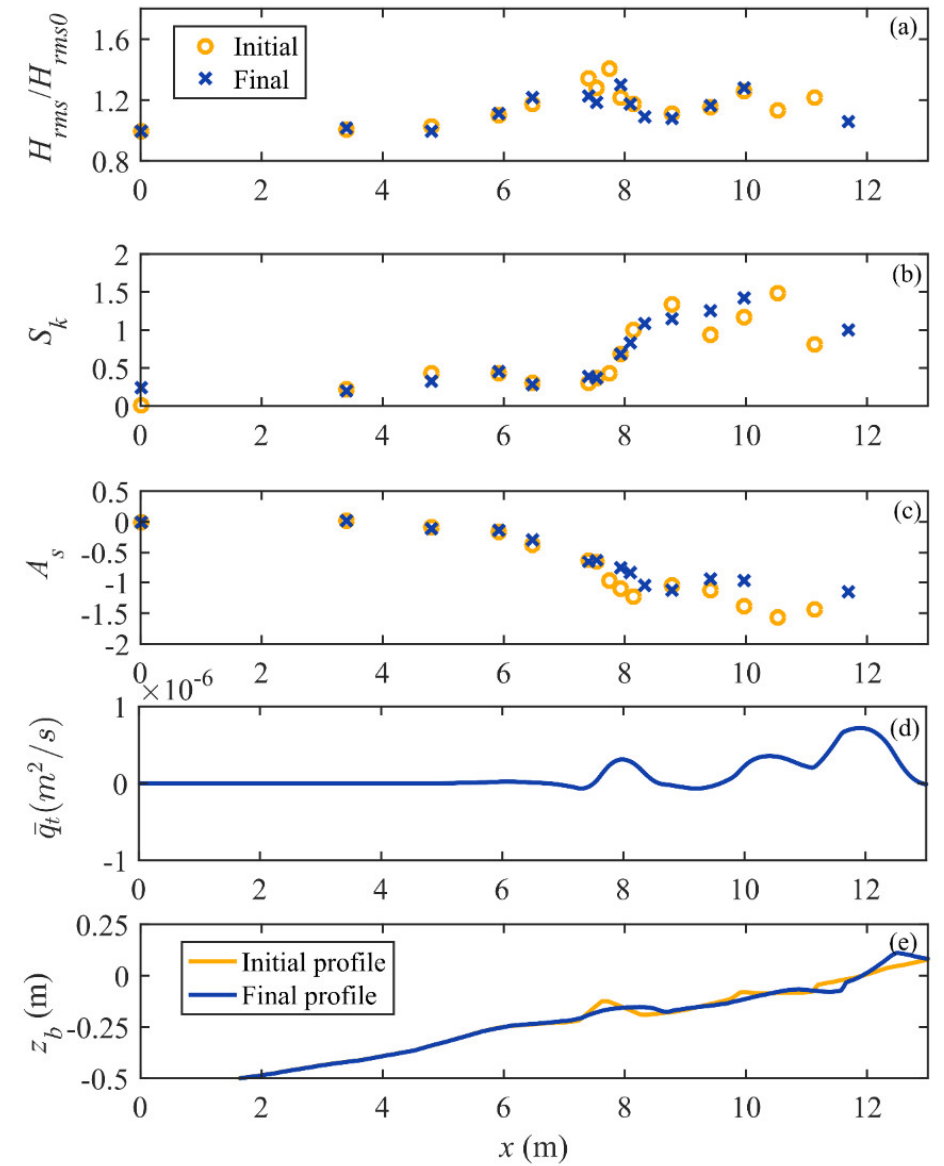
Figure 6. Measured ( a ) normalized root-mean-square wave height, ( b ) wave skewness, ( c ) wave asymmetry, ( d ) time-averaged sediment transport rate across the ( e ) initial and final profiles for case E1_1. Subscript ‘0′ means the quantity at x = 0 m.